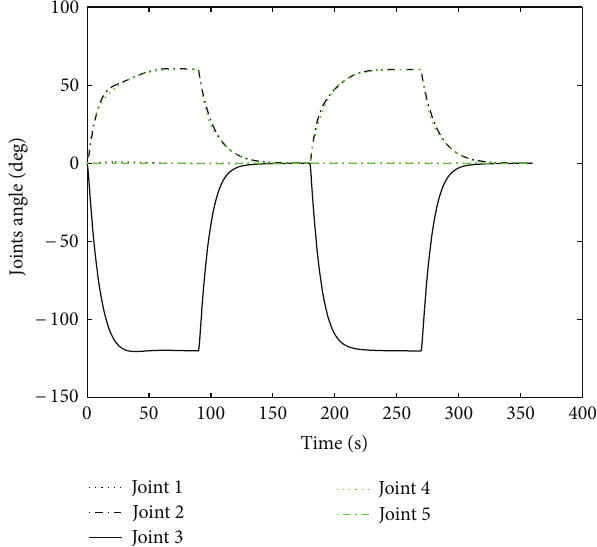
Figure 14: The joints’ displacement profiles for the inchworm gait.